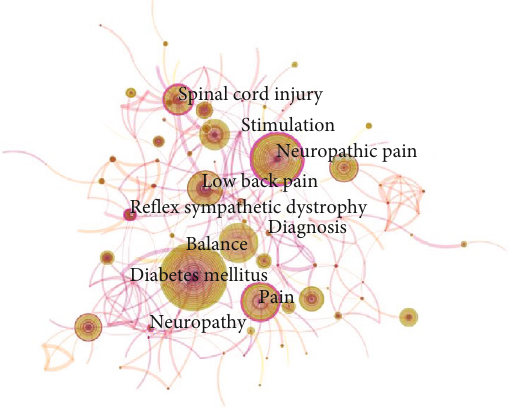
Figure 8: Network map of keyword cooccurrence in neuropathic pain rehabilitation research from 2000 to